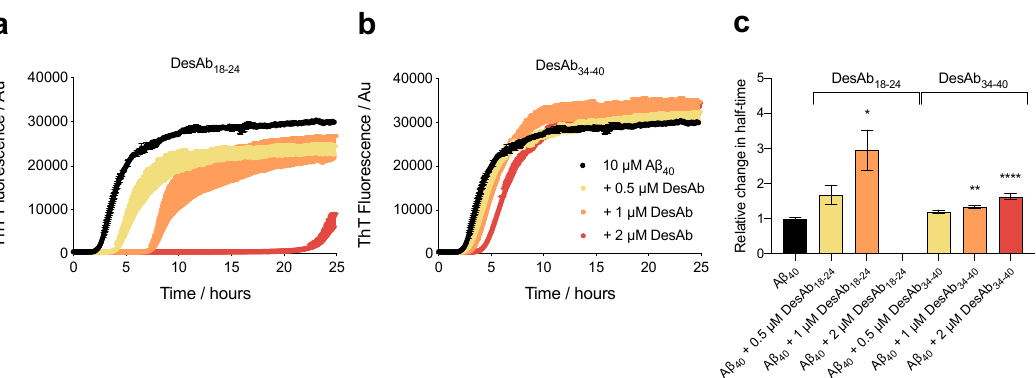
Figure 1. DesAb 18-24 and DesAb 34-40 inhibit A β 40 aggregation. ( a , b ) Thioflavin T (ThT) fluorescence intensity profiles for the aggregation of A β 40 (10 µ M) incubated in the absence (black) and presence of 0.5 µ M (yellow), 1 µ M (orange) and 2 µ M (red) DesAb 18-24 ( a ) and DesAb 34-40 ( b ). Upward error bars indicate standard error of the mean (SEM) of three technical replicates. ( c ) Relative change in half-time (t 1 / 2 ) calculated from dividing t 1 / 2 for each experimental condition by the average t 1 / 2 determined for A β 40 in the absence of DesAbs to show the relative delay in aggregation induced by the antibodies. Error bars indicate SEM of three technical replicates. Individual antibody groups were analyzed by one-way ANOVA followed by a Bonferroni’s multiple comparison test relative to A β 40 in bu ff er. The symbols *, **, and **** indicate p < 0.05, 0.01 and 0.0001, respectively.